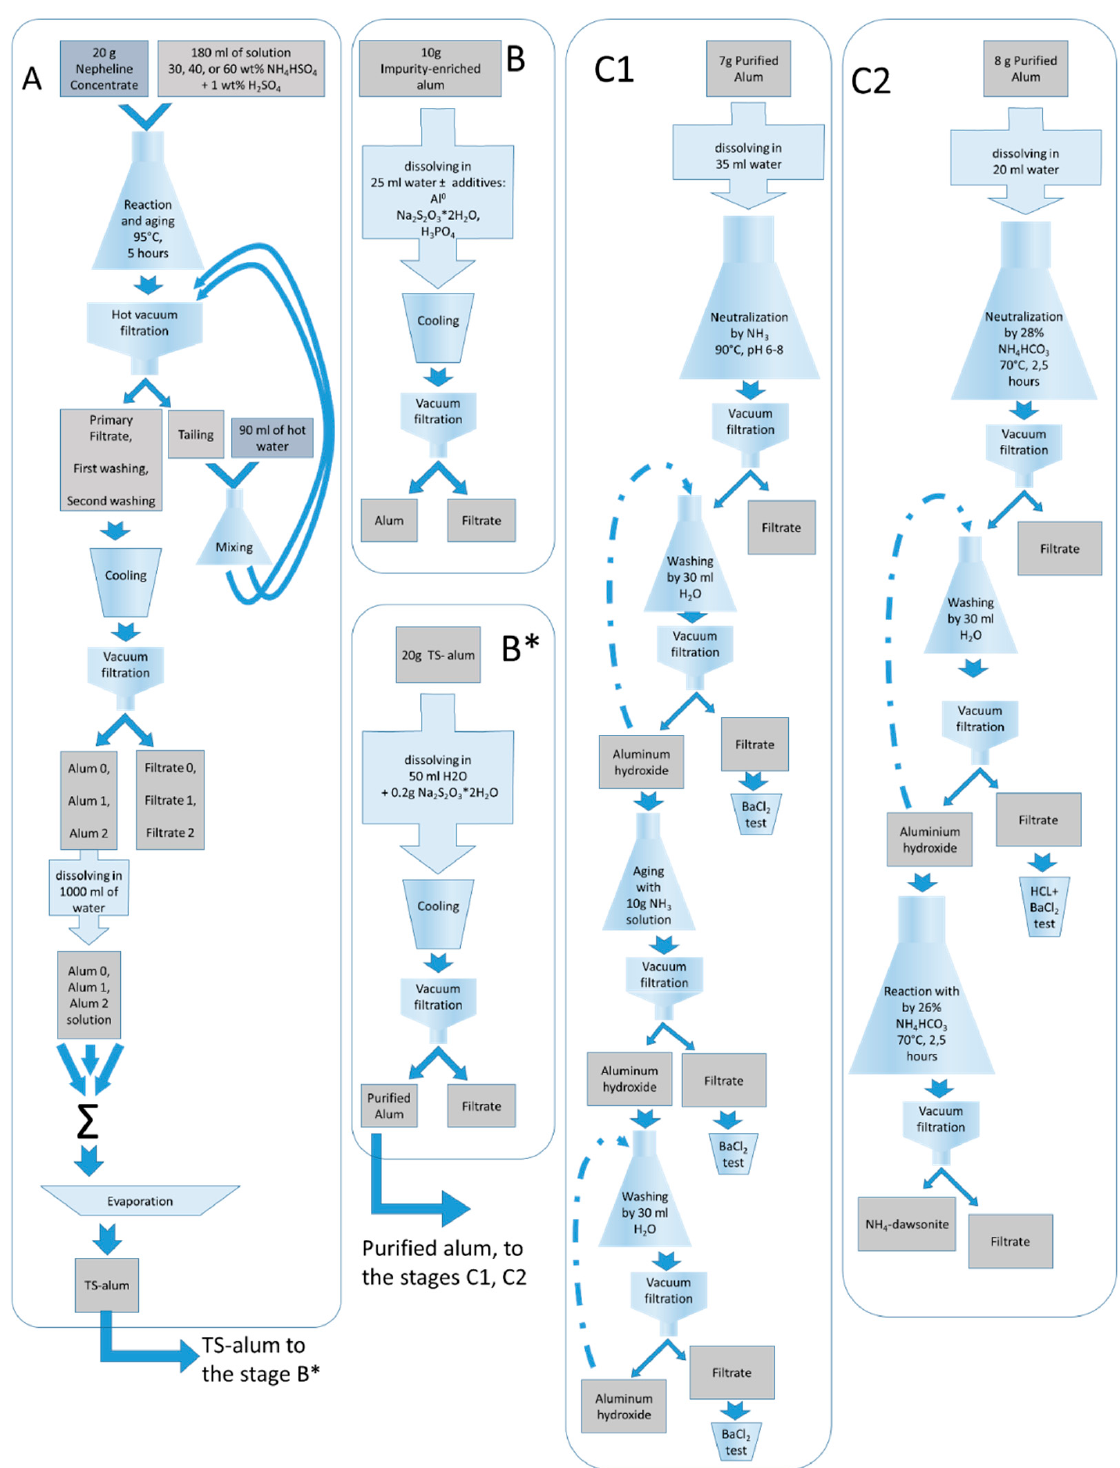
Figure 4. Schematic diagram of experiments: ( A ) nepheline decomposition; ( B ) alum recrystallization (B*–variant, used for obtaining purified alum for the future experiments); ( C ) alumina product precipitation stages: C1– for aluminum hydroxide, C2– for ammonium aluminum carbonate hydroxide.